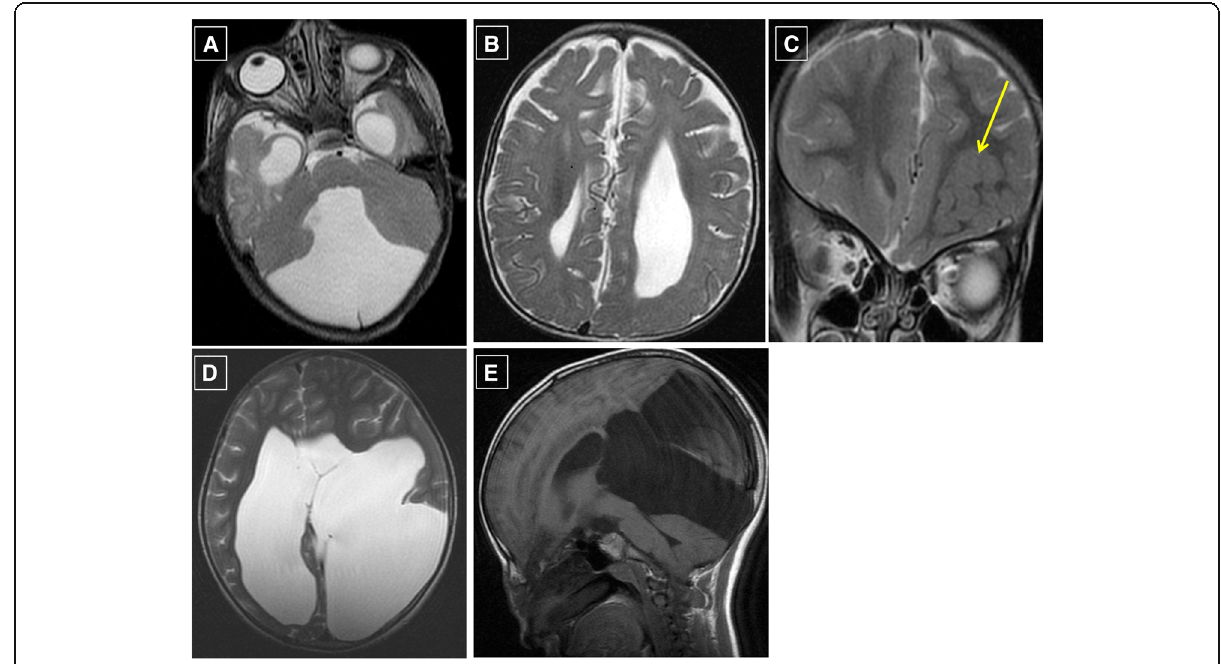
Fig. 10 Associated intracranial malformation. ( a ) (T2-weighted axial image): Dandy Walker malformation. ( b ) (T2-weighted axial image): Corpus callosal agenesis. ( c ) (T2-weighted coronal image): Heterotropia (arrow). ( d ) (T2-weighted axial image): Large open lip schizencephaly. ( e ) (T1- weighted sagittal image): Posterior fossa arachnoid